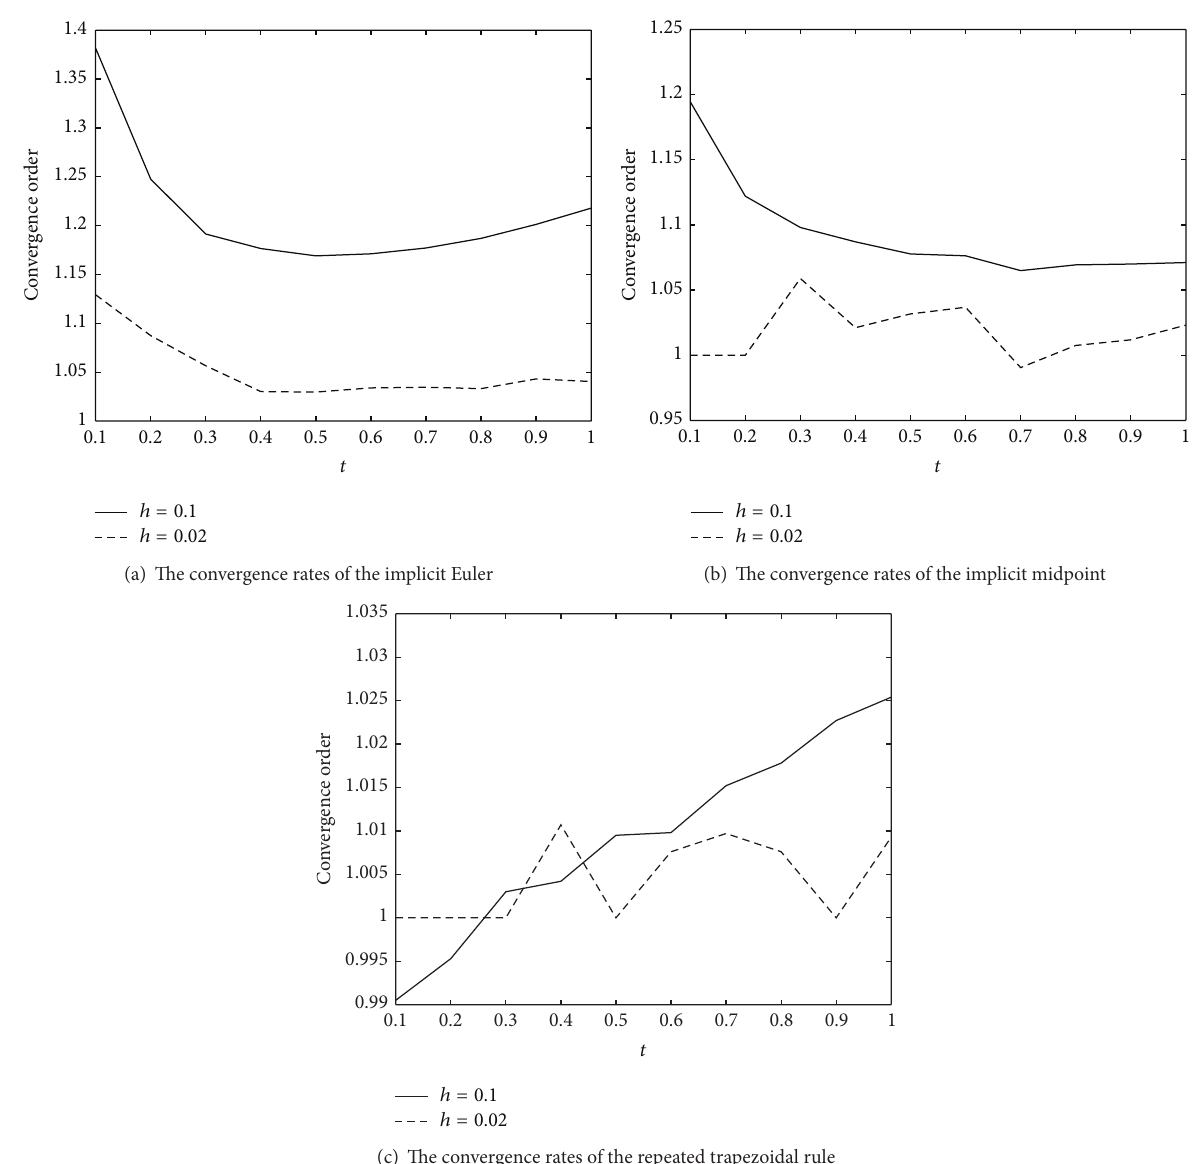
(c) The convergence rates of the repeated trapezoidal rule Figure 2: The convergence rates for